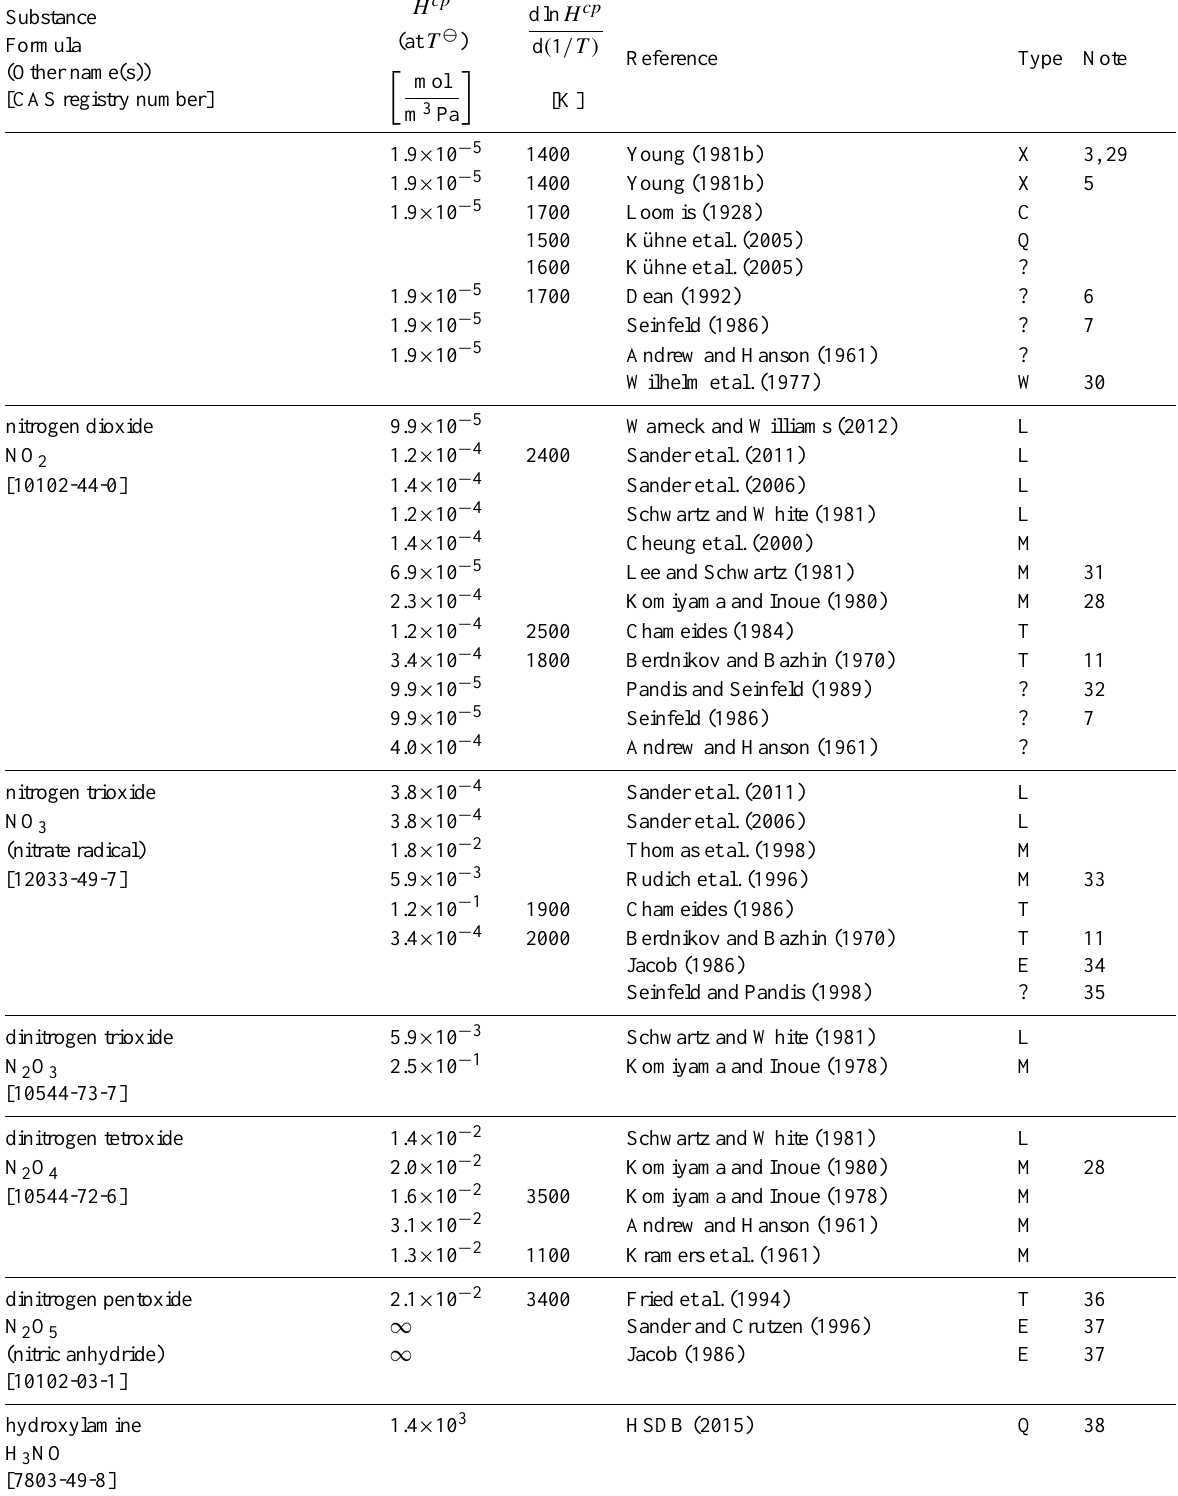
Table 6: Henry’s law constants for water as solvent